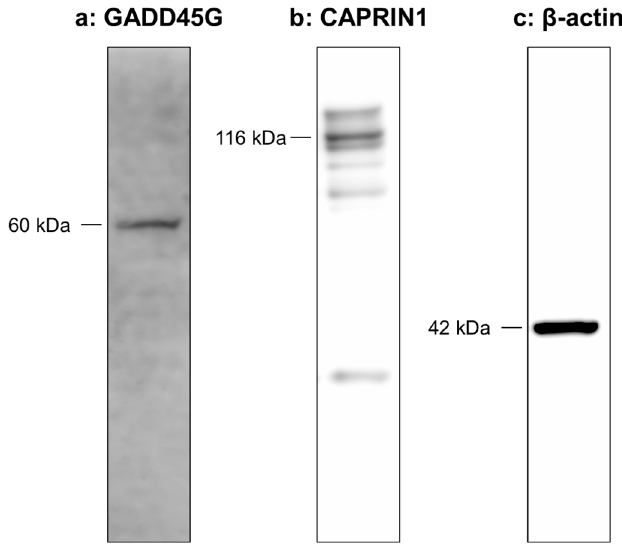
Figure 6 . Western blotting of GADD45G ( a ) and CAPRIN1 ( b ) expression in cultured human nucleus pulposus (NP) cells. β -actin ( c ) served as a loading control.